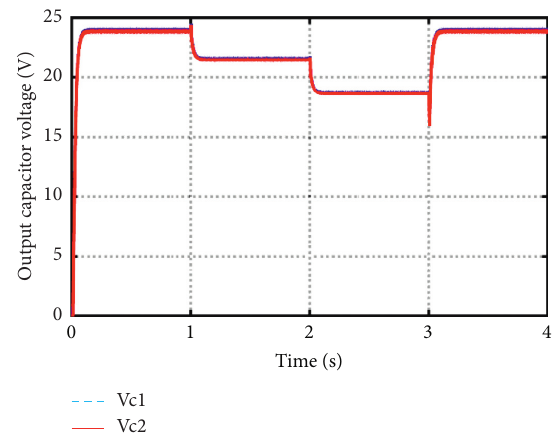
Figure 16: Output capacitor voltages of TLB converter.